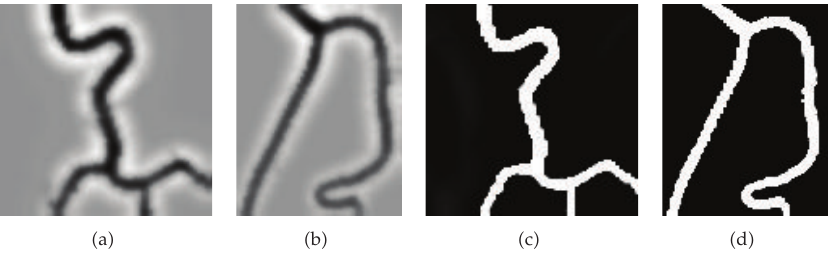
Figure 5: Comparison of the final level set function φ between the LBF model and the proposed model. (cid:6) a (cid:7) and (cid:6) b (cid:7) are the final φ for the LBF model. (cid:6) c (cid:7) and (cid:6) d (cid:7) are the final φ for the the proposed